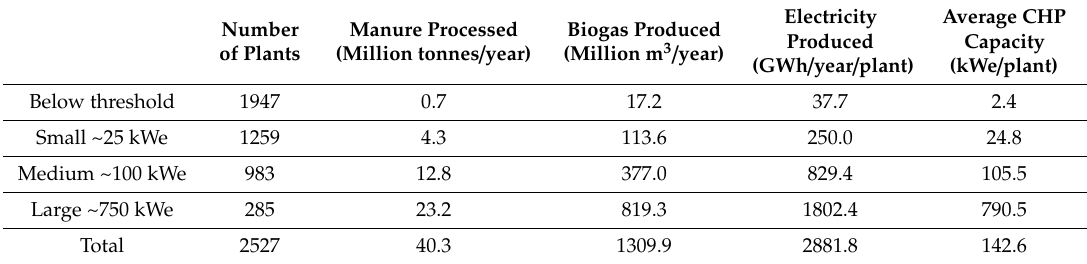
Table 5. Potential number of manure-based biogas plants in Ukrainian agricultural enterprises.